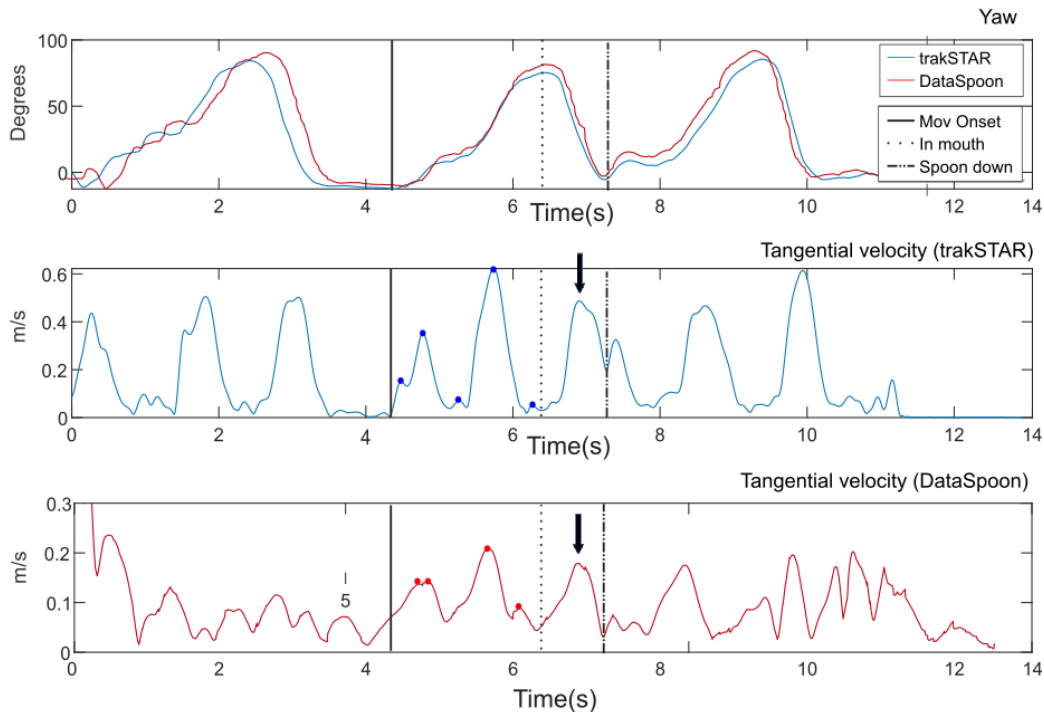
Figure 4. Tangential velocity profiles from trakSTAR (middle panel) and DataSpoon (bottom panel). Yaw for both systems is depicted in the top panel for comparison. One movement duration is marked for both devices. The number of peaks in the tangential velocity profile (i.e., zero crossings in the acceleration profile) is marked for the first part of movement (“to mouth”), and the peak velocity is marked for the second part (“from mouth”).